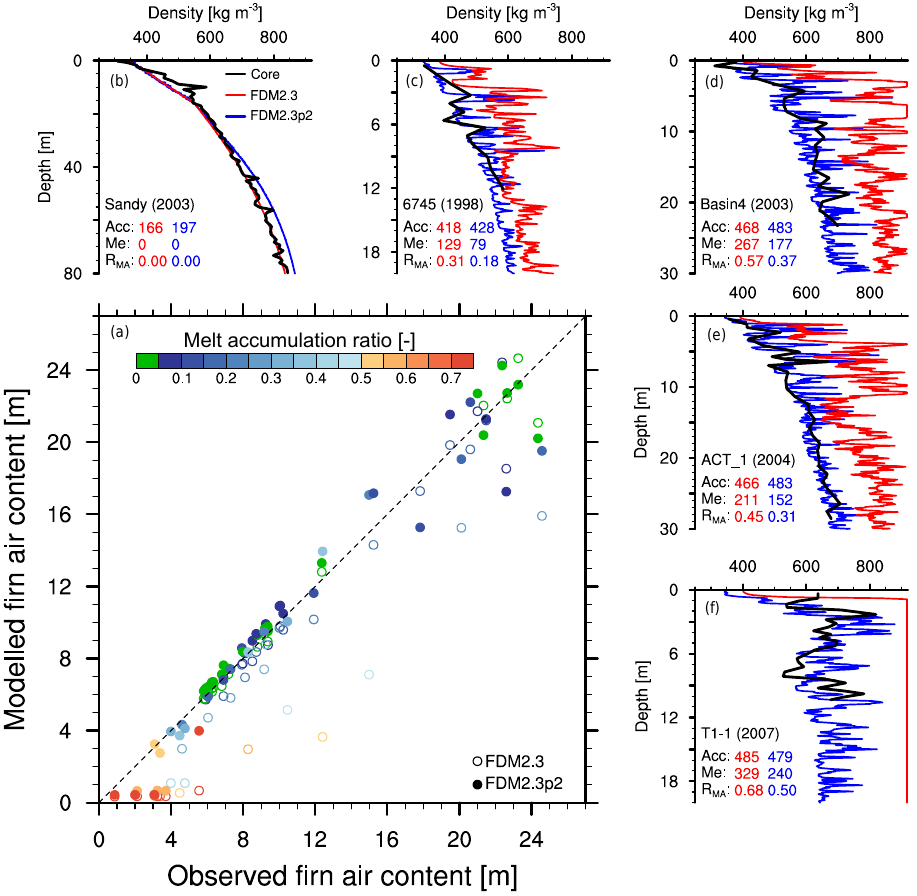
Figure 1. Evaluation of simulated firn density: (a) modelled vs. observed firn air content for FDM2.3 (open circles) and FDM2.3p2 (closed circles) at 62 firn core locations on the GrIS; (b–f) vertical firn density profiles of five selected cores (black), FDM2.3 simulation (red), and FDM2.3p2 simulation (blue). The colours in (a) represent the melt-accumulation ratio of the core location, where green, blue, and red colours indicate the three categories as specified in Sect. 3. In (b–f) , the core name and date (black print) is provided, as well as the 1990–2009 average accumulation (“Acc” in mmw.e.yr − 1 ), 1990–2009 average surface melt (“Me” in mmw.e.yr − 1 ), and the 1990–2009 melt-accumulation ratio ( R MA , unitless) as simulated by RACMO2.3 (red print) and RACMO2.3p2 (blue print). Core names and locations can be found in Fig.